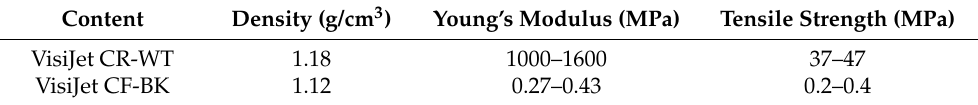
Table 1. Properties of the materials to make the composites with integrated hard and soft phases.